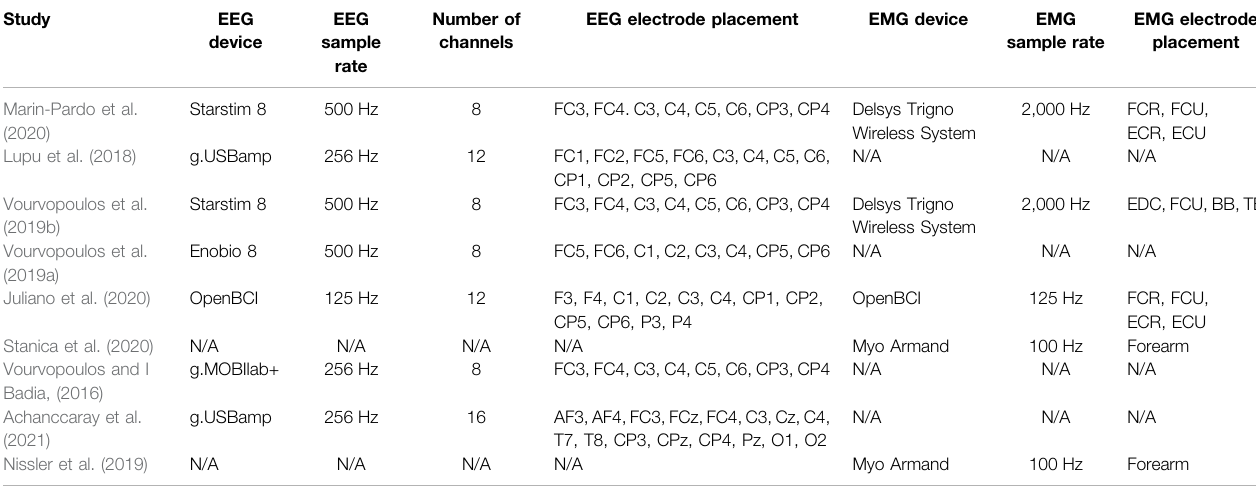
TABLE 2 | Detailed information about devices used for physiological computing.